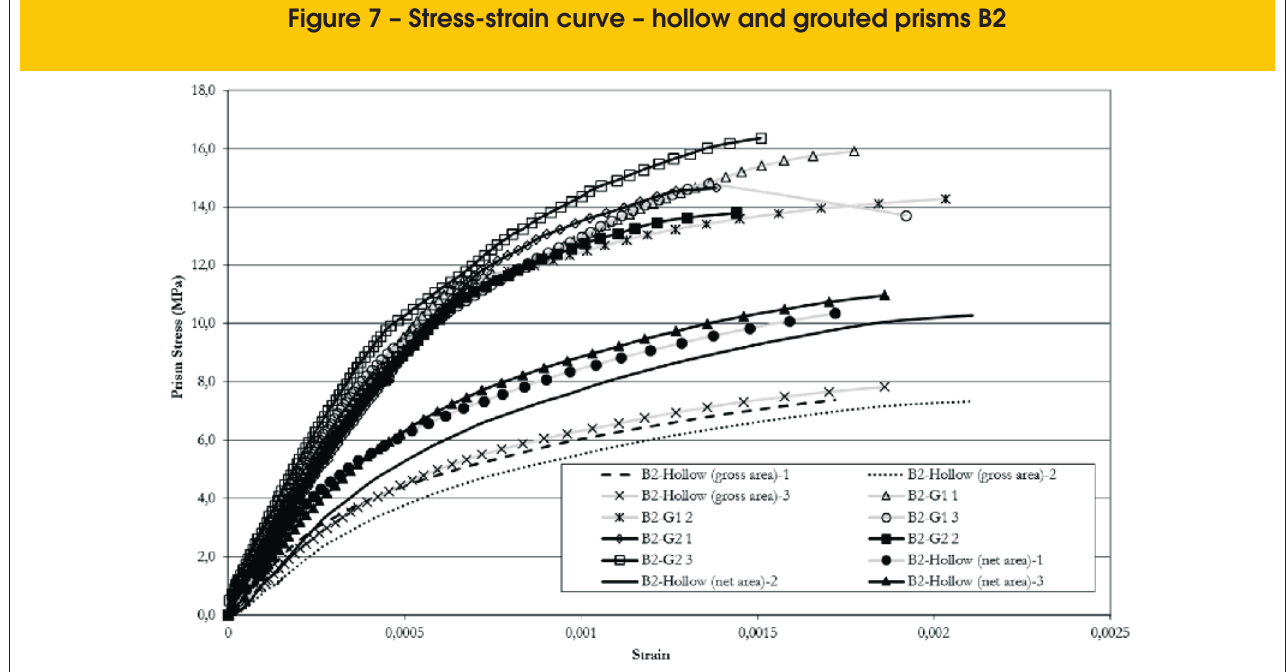
Figure 7 – Stress-strain curve – hollow and grouted prisms